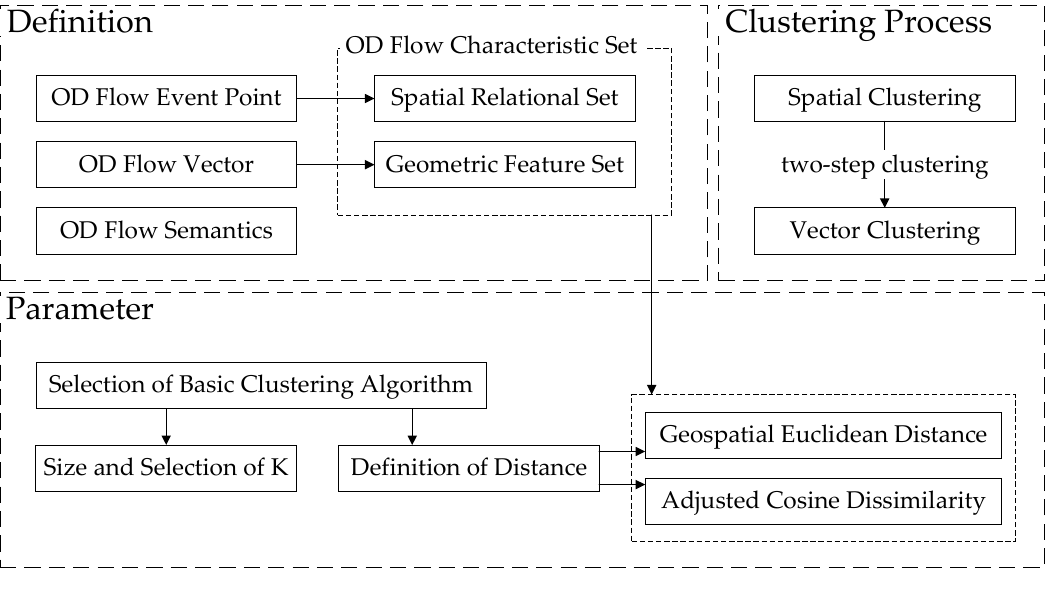
Figure 1. Component diagram of method related concepts.